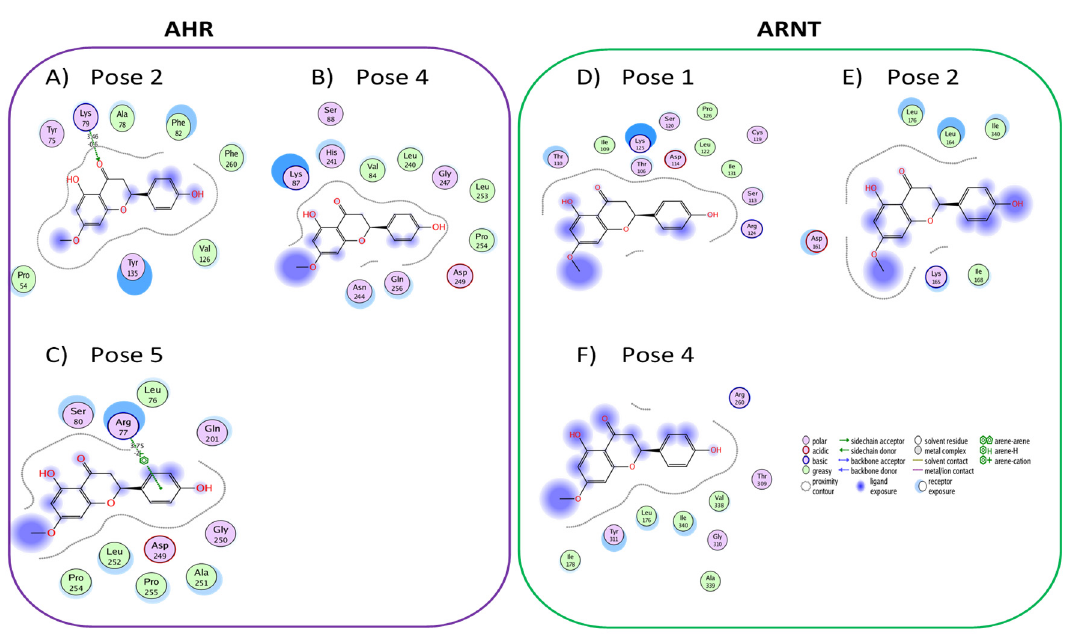
Figure 12. Interaction network between monomeric protein AHR, ARNT and the studied compound 15 .